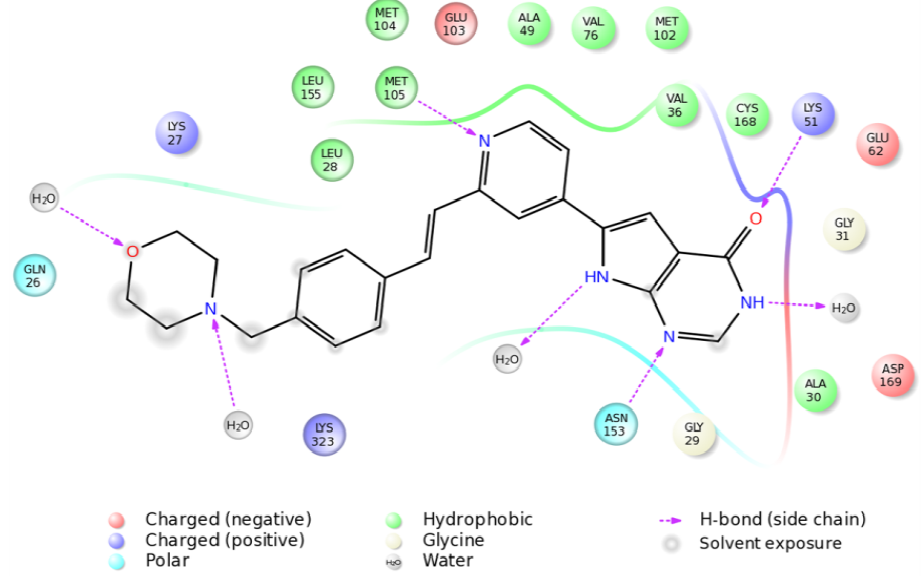
Figure 8. 2D plot of the stable inhibitor binding pose observed during the 100 ns MD. Amino acids and water molecules within 4 Å from the inhibitor are included in the